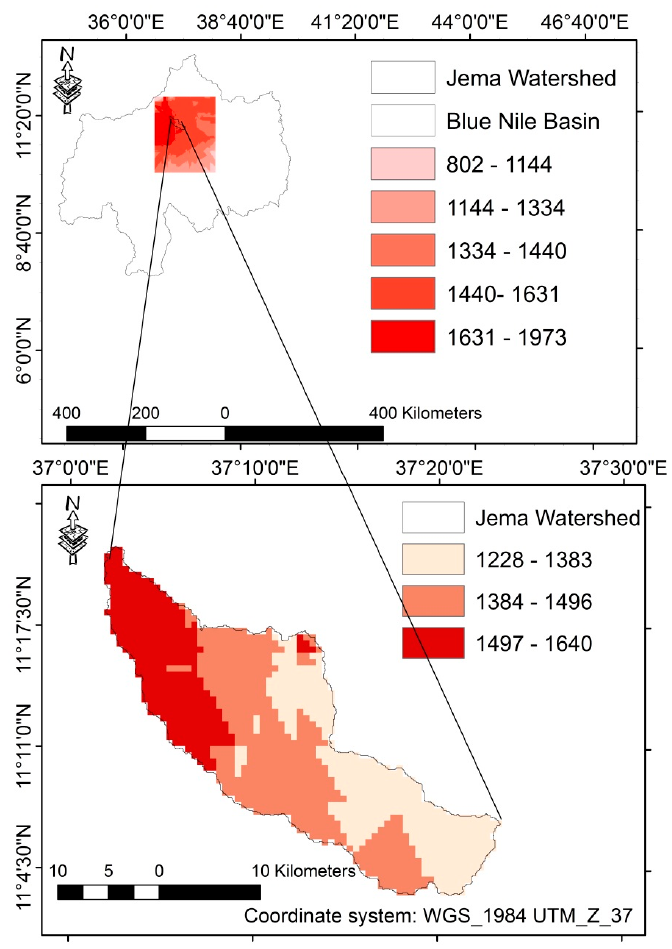
Figure 8. Krigged values of the mean annual total rainfall_MATRF (mm) in the elevation zones of the Jema watershed.